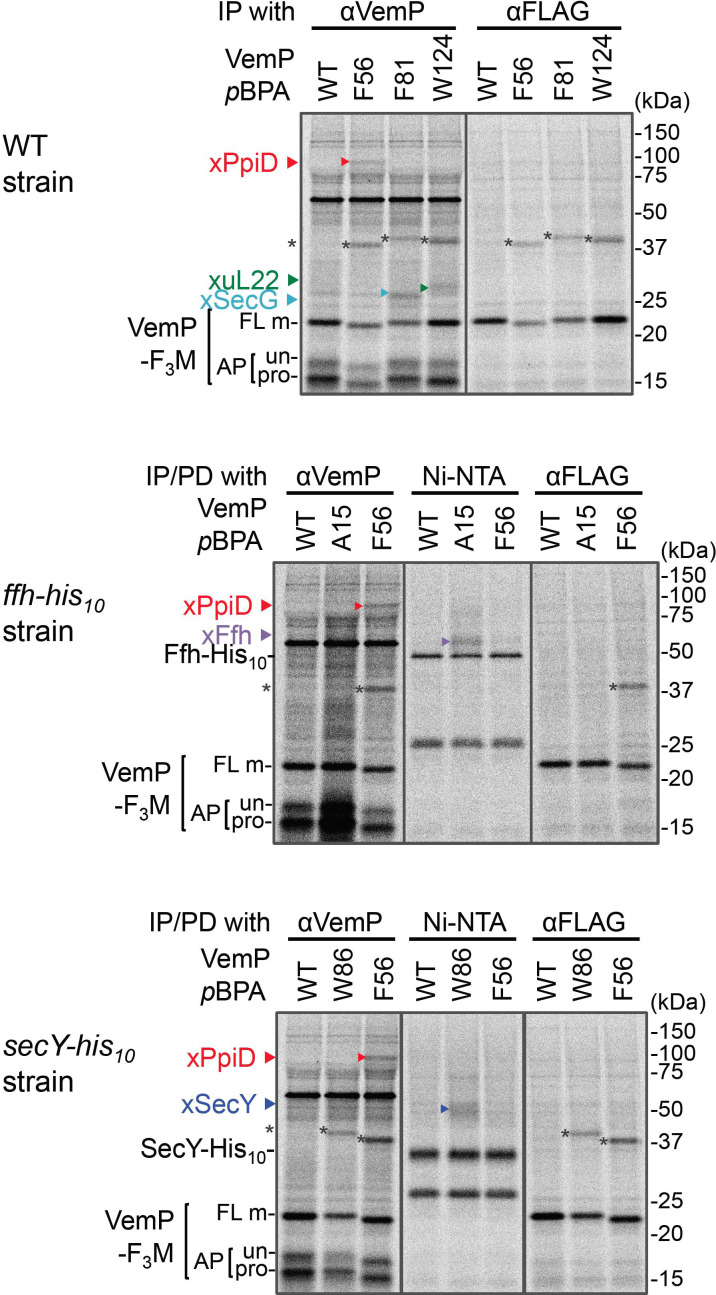
Immunoprecipitation of VemP-crosslinked products using anti-FLAG antibodies.The cells of the indicated strains were grown, induced to express a VemP-F3M derivative with pBPA at the indicated position (WT indicates the protein with no pBPA), and analyzed by PiXie as in Figure 1. Labeled proteins were subjected to IP with the indicated antibodies or pull-down with Ni-NTA agarose. Immuno-isolated proteins were analyzed as in Figure 1. The result shown is a representative of two technical replicates. The VemP XLs with PpiD, uL22, SecG, SecY-His10, and Ffh-His10 are marked by triangles colored in red, green, pale blue, blue, and violet, respectively. Asterisks presumably represent crosslinked dimer forms of full-length VemP-F3M.